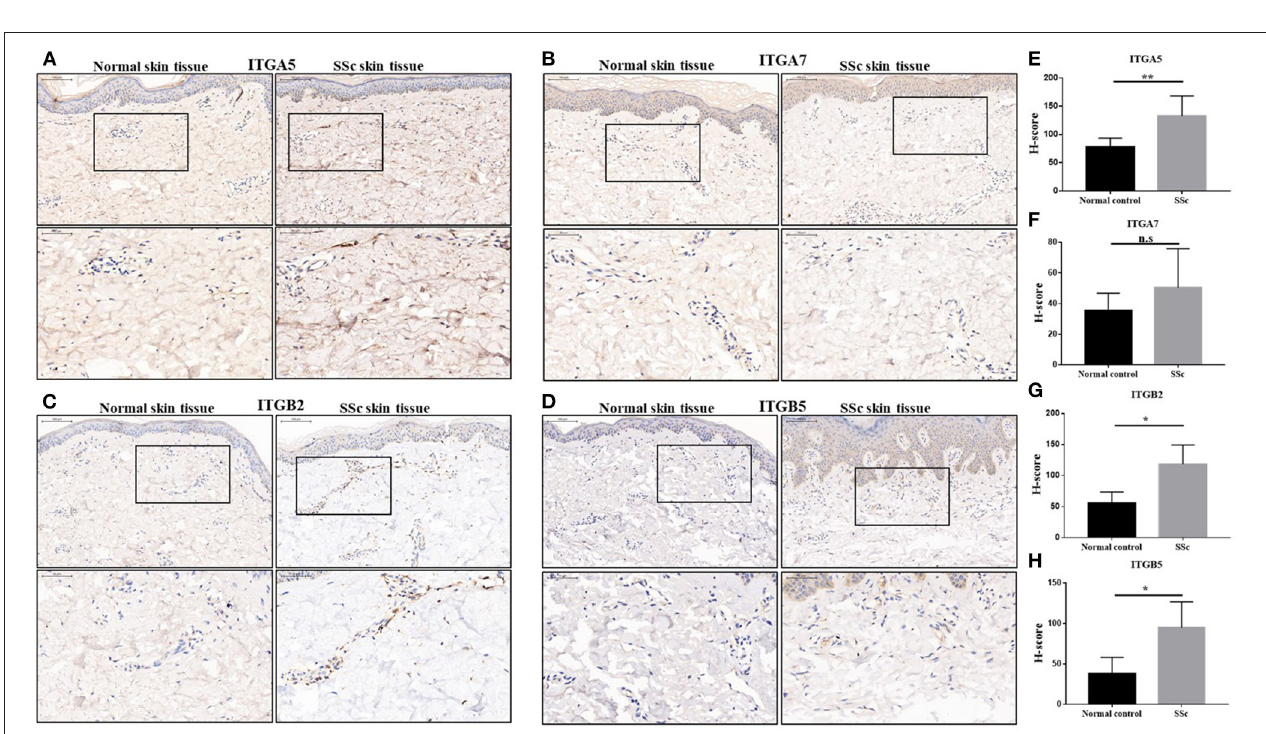
FIGURE 2 | The protein expressions of integrin α 5, integrin α 7, integrin β 2, and integrin β 5 in the skin tissues of SSc patients. (A–D) Representative images of integrin α 5, integrin α 7, integrin β 2, and integrin β 5 immunohistochemical staining in the skin tissues of SSc patients and normal controls. (E–H) Comparison of the H-score values of integrin α 5, integrin α 7, integrin β 2, and integrin β 5 in SSc patients and normal control. The data are represented as mean ± SD. Statistical differences were performed using the Mann–Whitney test. * p < 0.05, ** p < 0.01. SSc, systemic sclerosis.